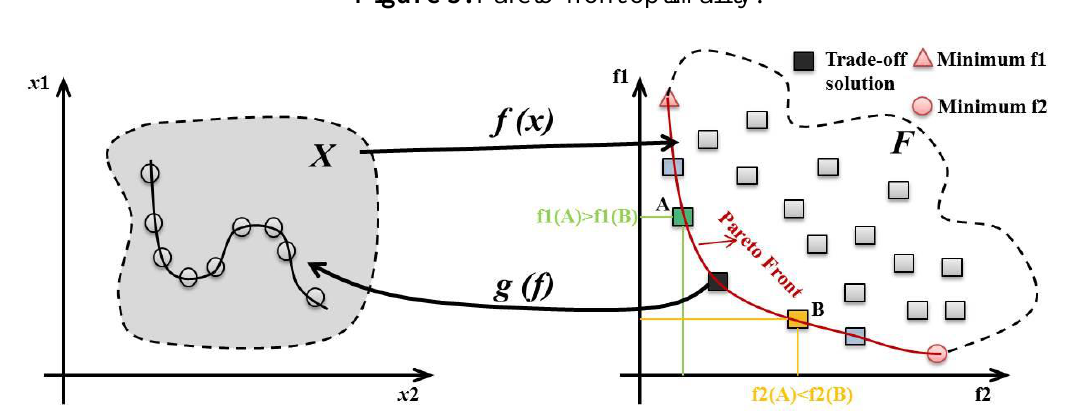
Figure 3. Pareto-front